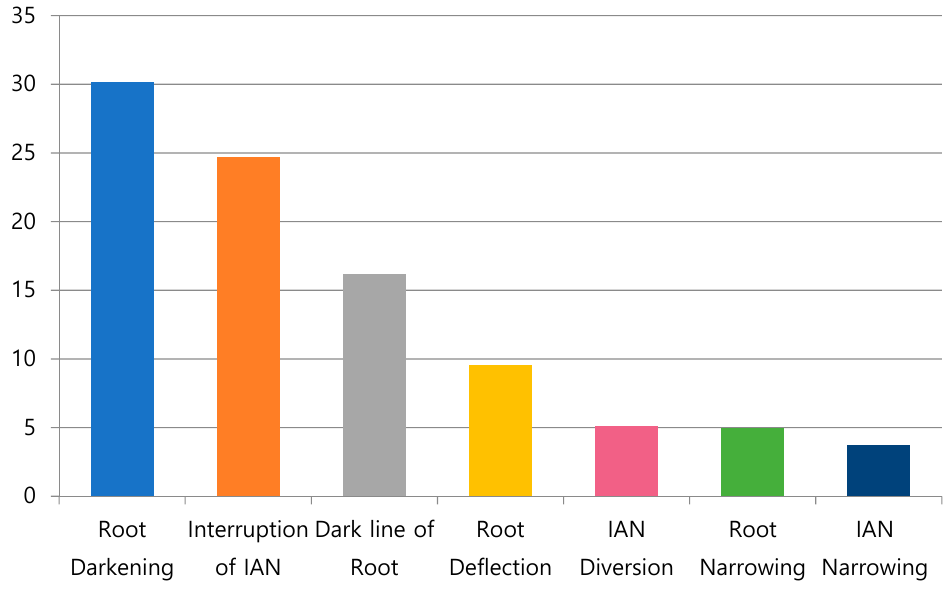
Figure 7. Distributions of panoramic signs: root darkening (30.2%), interruption of the inferior alveolar nerve (IAN) (24.7%), dark line of the root (16.2%), root deflection (9.6%), IAN diversion (5.1%), root narrowing (5.0%), and IAN Narrowing (3.7%).